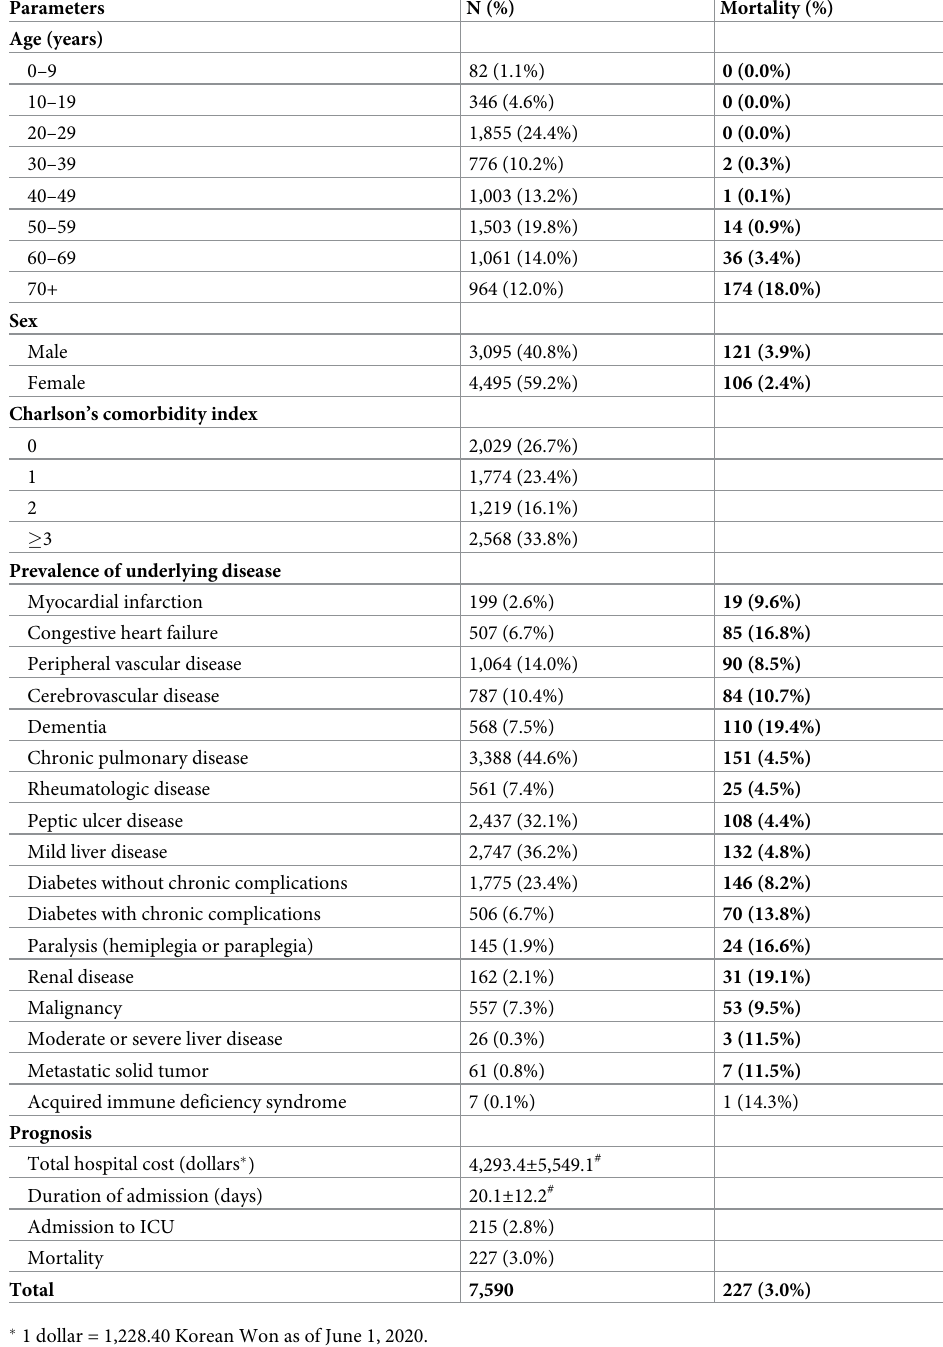
Table 1. Clinical characteristics and outcomes of patients with